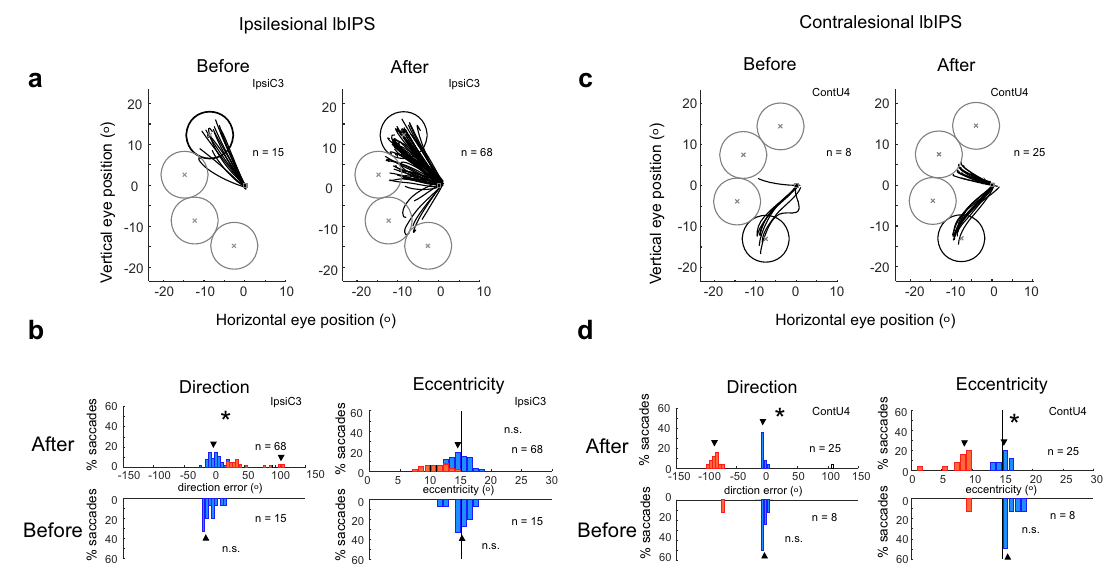
Fig. 7 Saccade trajectories and endpoints in example sessions before and after lbIPS inactivation. a , b Saccade trajectories and the distribution of saccade endpoints (direction and eccentricity) in a single session (monkey C, IpsiC3). c , d Saccade trajectories and the distribution of saccade endpoints (direction and eccentricity) in a single session (monkey U, contU4). Circles in a and b indicate target windows (the circle with the thick line indicates target location). b , d The distribution of error angles in direction (left) and eccentricity (right) before (lower) and after (upper) lbIPS inactivation. The multimodality of distribution evaluated by Silverman ’ s test ( p < 0.05) is indicated by an asterisk in each panel. Arrowheads indicate local modes estimated by Silverman ’ s test. Blue and red columns indicate correct saccades and error saccades, respectively. An open column indicates the saccades removed from the analysis as outliers. For session IDs (IpsiC3 and ContC2), see Supplementary Table